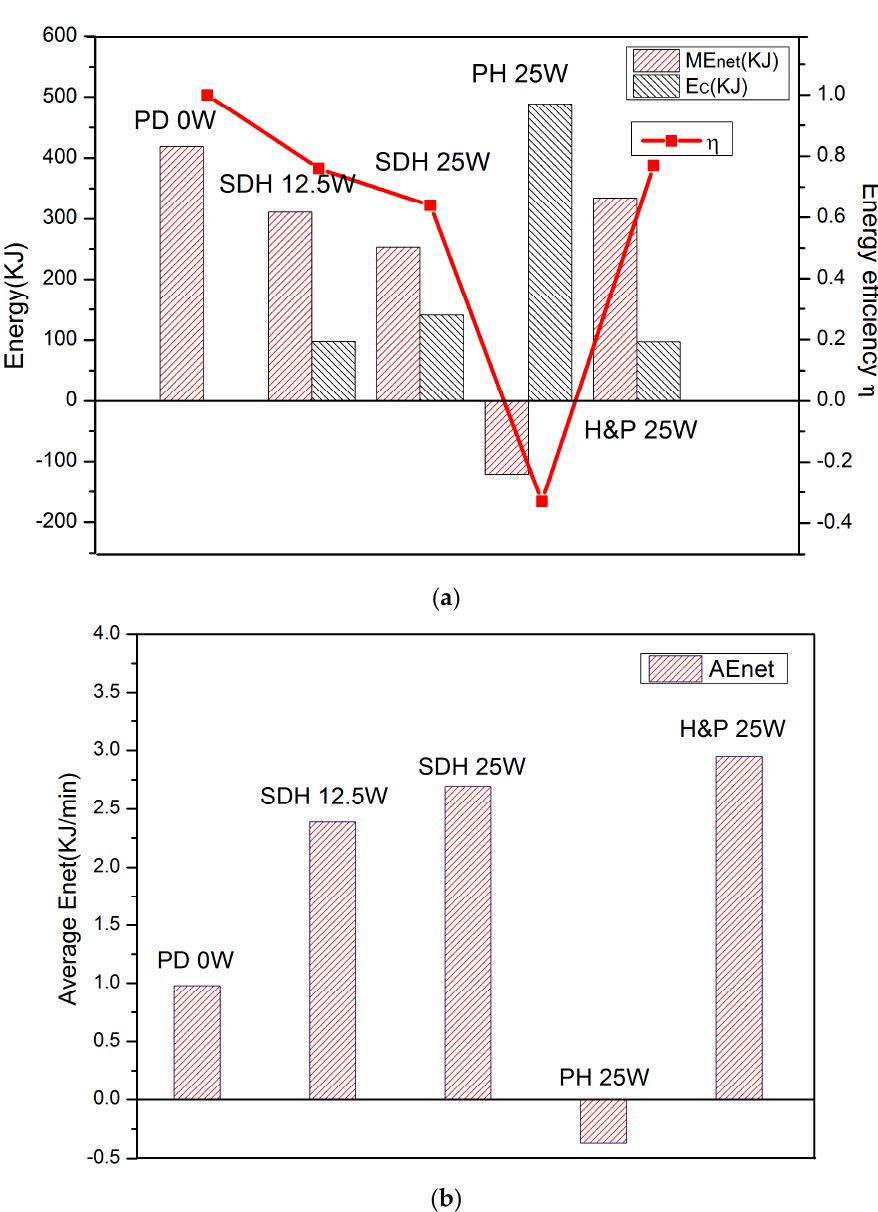
Figure 8. ( a ) The comparison of the M E net , E C and η in the five Runs; ( b ) The average net energy of five Runs.